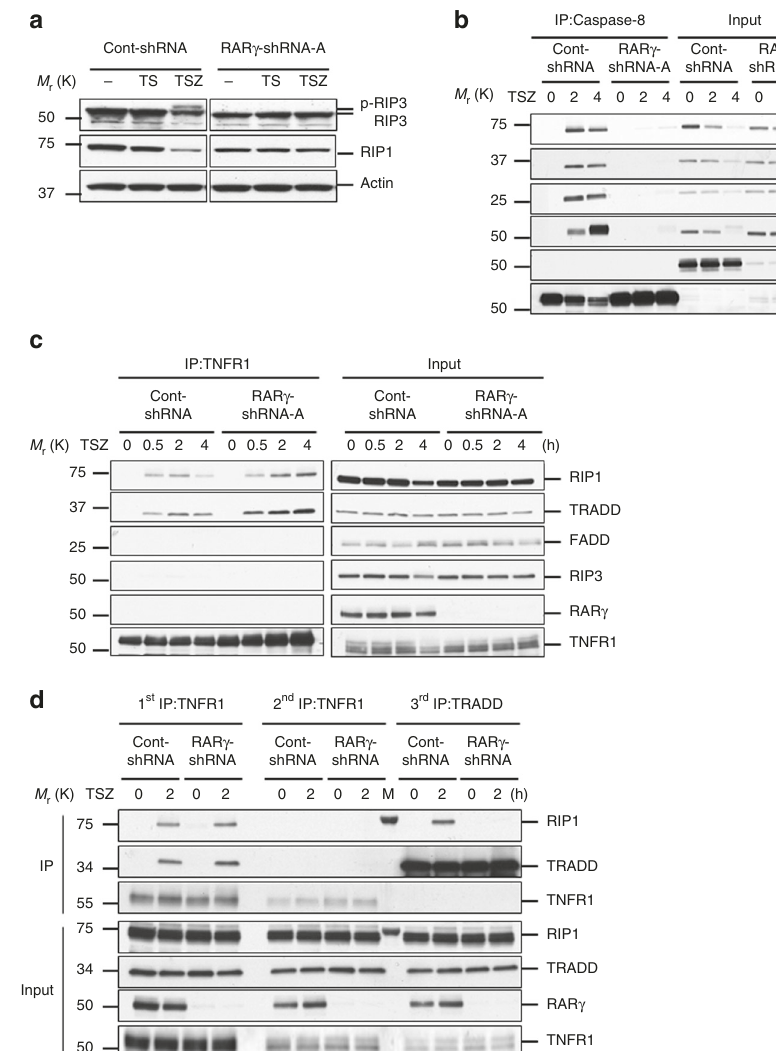
Fig. 3 RAR γ has a role in the formation of death complexes. a Western blot analysis of HT-29 cont-shRNA, and RAR γ -shRNA-A treated with DMSO, TS or TSZ for 24 h and cell lysates were immunoblotted with the indicated antibodies. b , c Immunoprecipitation of HT-29 cont-shRNA or RAR γ -shRNA-A cells treated with TSZ for the indicated time. Cell lysates were collected and immunoprecipitated with anti-Caspase-8 antibody b or anti-TNFR1 antibody c . The immunoprecipitated complexes were immunoblotted with the indicated antibodies. d Sequential immunoprecipitation of HT-29 cont-shRNA or RAR γ -shRNA-A cells treated TSZ for 2 h. First IP : TNFR1 complex I was immunoprecipitated using anti-TNFR1 antibody. Second IP : the remaining lysates were immunoprecipitated again with anti-TNFR1 antibody. Third IP : the remaining lysates were then immunoprecipitated with anti-TRADD antibody. The immunoprecipitated complexes were analyzed by with the indicated antibodies. (M: marker). All blots above are representative of one of